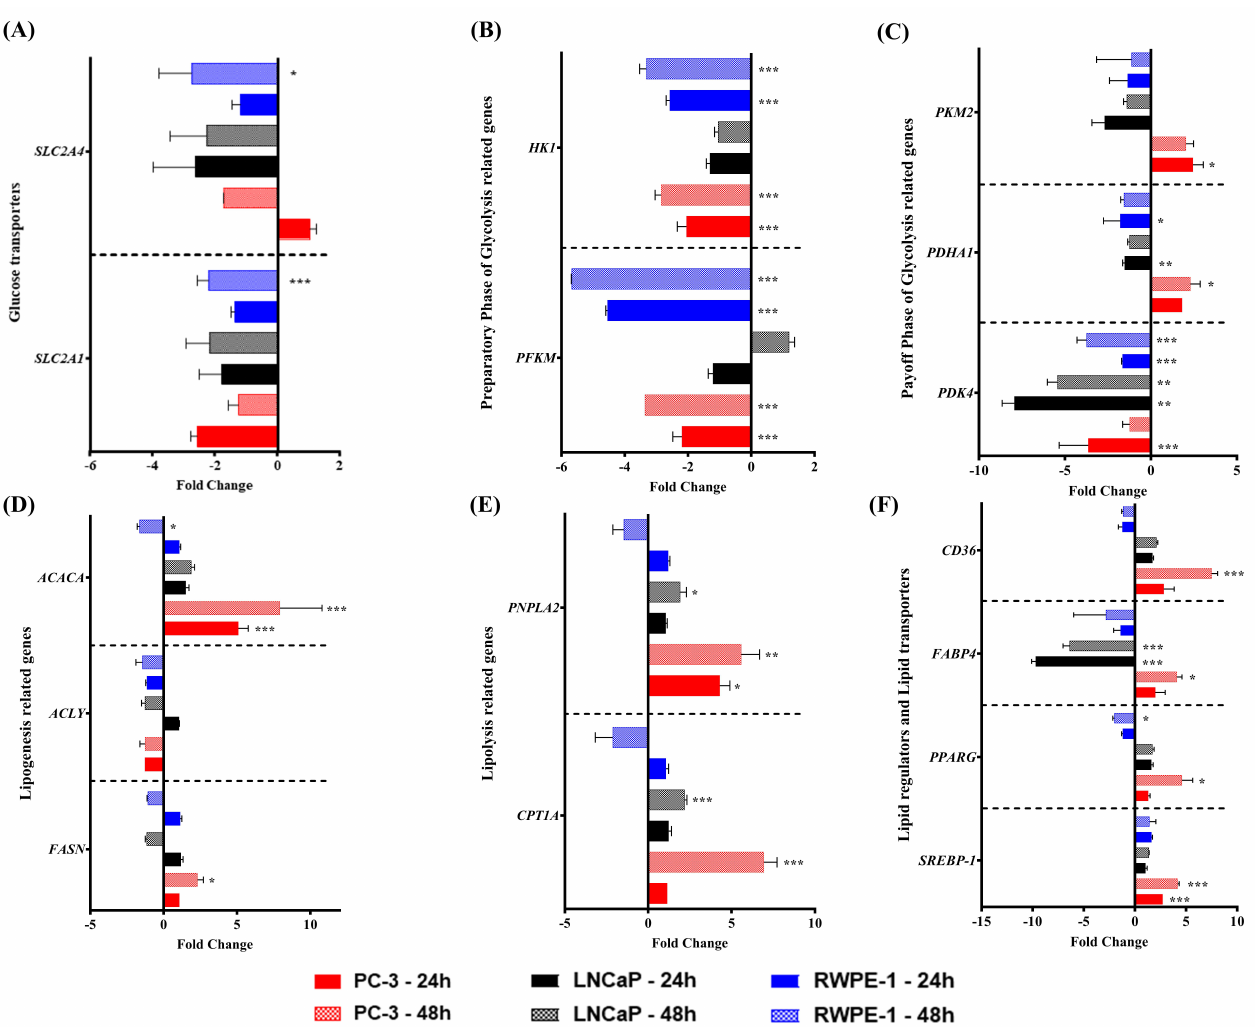
Figure 2. Effect of exogenous sTWEAK on the expression of the genes related to glucose and lipid metabolism. The glucose and lipid metabolism-related genes were evaluated by RT-qPCR after treating PC-3, LNCaP and RWPE-1 cells with 100 ng/mL TWEAK for 24 or 48 h. ( A ) Glucose transporters. ( B ) Preparatory phase of glycolysis. ( C ) Payoff phase of glycolysis. ( D ) Lipogenesis-related genes. ( E ) Lipolysis-related genes. ( F ) Lipid regulators and lipid transporter genes. Results are presented as the mean ± SEM of 4 independent experiments of the fold change expression with respect to the nontreated respective controls. * p < 0.05, ** p < 0.01 and *** p < 0.001. Abbreviations: SLC2A1 and SLC2A4 , glucose transporter 1 and 4, respectively; HK1 , hexokinase 1; PFKM , 6-phosphofructo-1-kinase; PKM2 , pyruvate kinase M2; PDHA1 , pyruvate dehydrogenase alpha 1; PDK4 , pyruvate dehydrogenase kinase 4; ACACA , acetyl-CoA carboxylase alpha; ACLY , ATP-citrate synthase; FASN , fatty acid synthase; PNPLA2 , patatin-like phospholipase domain containing 2; CPT1A , carnitine palmitoyltransferase 1A; CD36 , CD36 molecule; FABP4 , fatty acid-binding protein 4; PPARG , peroxisome proliferator- activated receptor gamma; SREBP-1 , sterol regulatory element-binding transcription factor 1; PC-3, androgen-independent human advanced adenocarcinoma prostate cancer cell line, LNCaP, androgen-sensitive human prostate adenocarcinoma cell line; RWPE-1 epithelial cell line derived from the peripheral zone of a histologically normal adult human